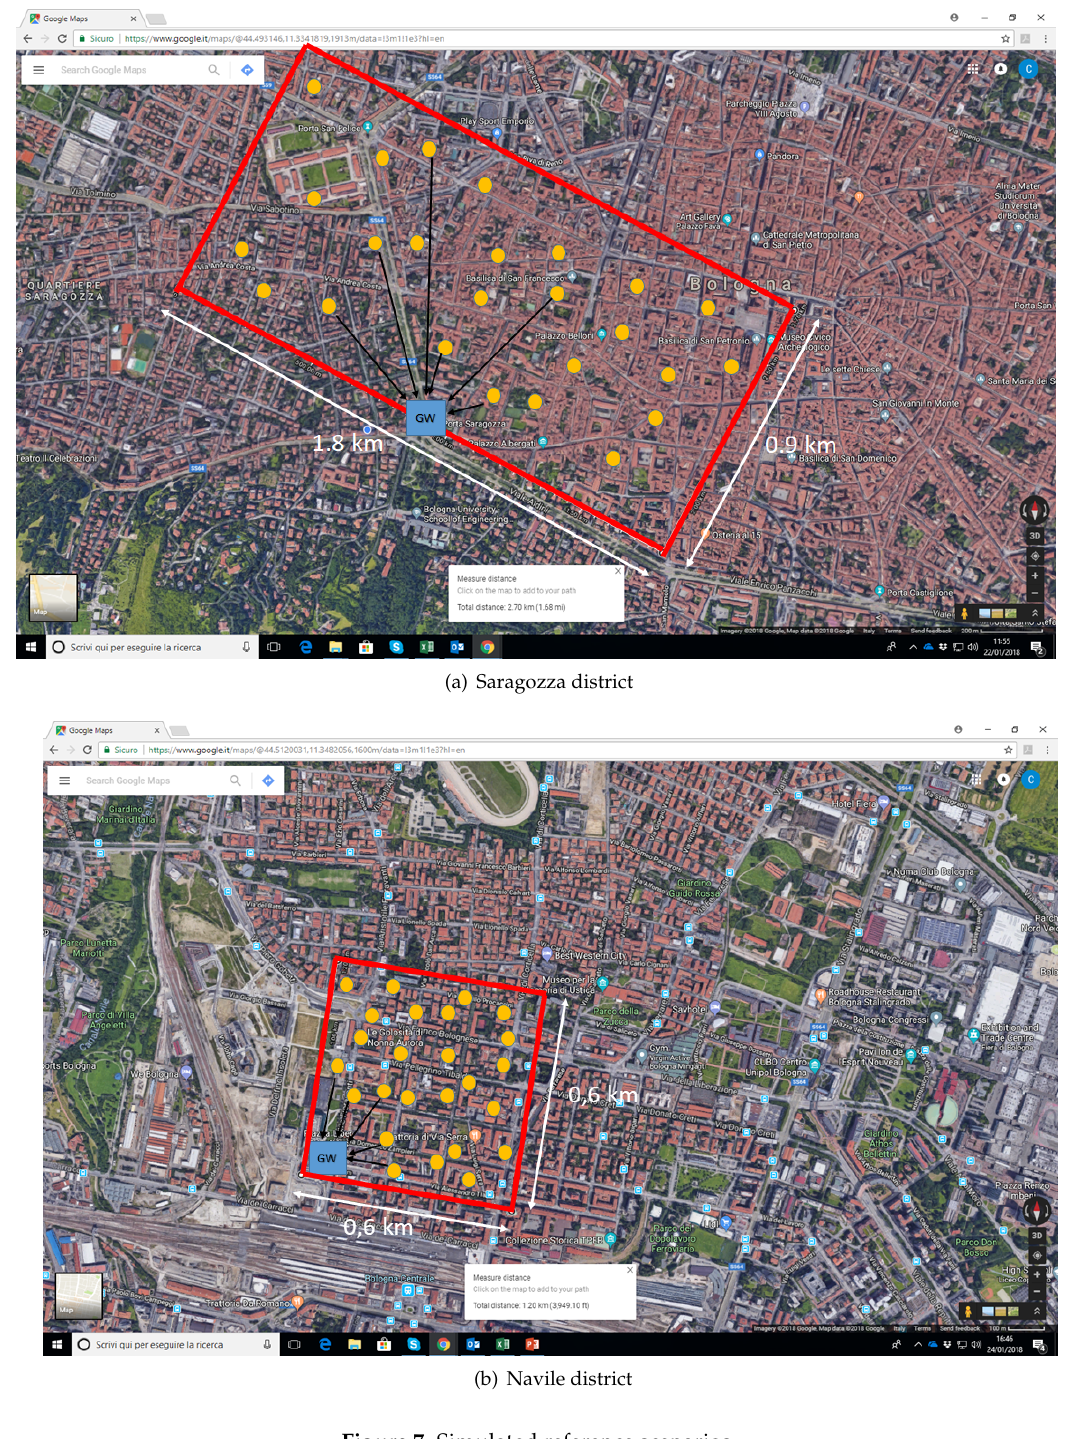
Figure 7. Simulated reference